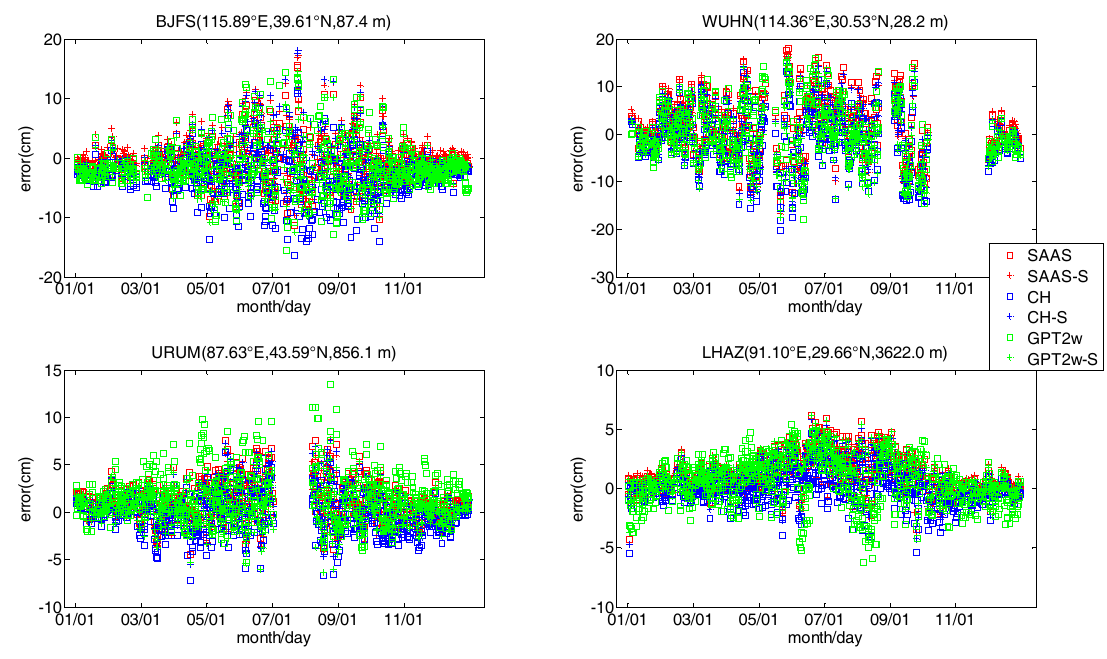
Figure 8. Changes in the error for the tropospheric models at the IGS stations. Table 4. Statistical results for all tropospheric models computed by using data from 2013 for four IGS stations (unit: cm).